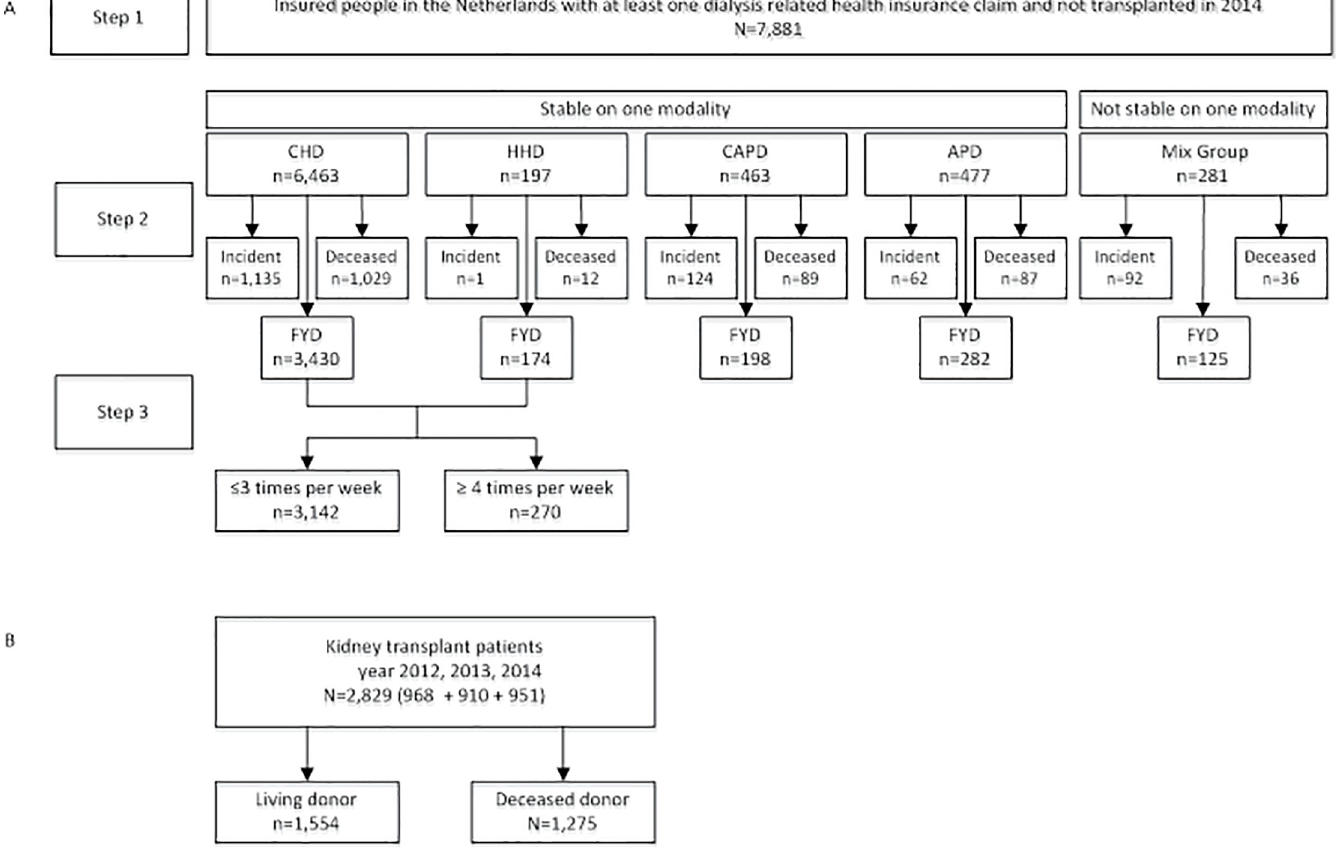
Fig 1. Classification of RRT modalities. Note: Fig 1A: Classification of dialysis patients; CHD = Centre Haemodialysis; HHD = Home Haemodialysis; APD = Automated Peritoneal Dialysis; CAPD = Continuous Ambulatory Peritoneal Dialysis; Mix Group = dialysis modality changed in 2014; FYD = full year on dialysis; Fig 1B: Classification of transplantation patients. We included only the first received kidney transplantation in the study period of 2012–2014. � Excluded patients are not represented in the figure.